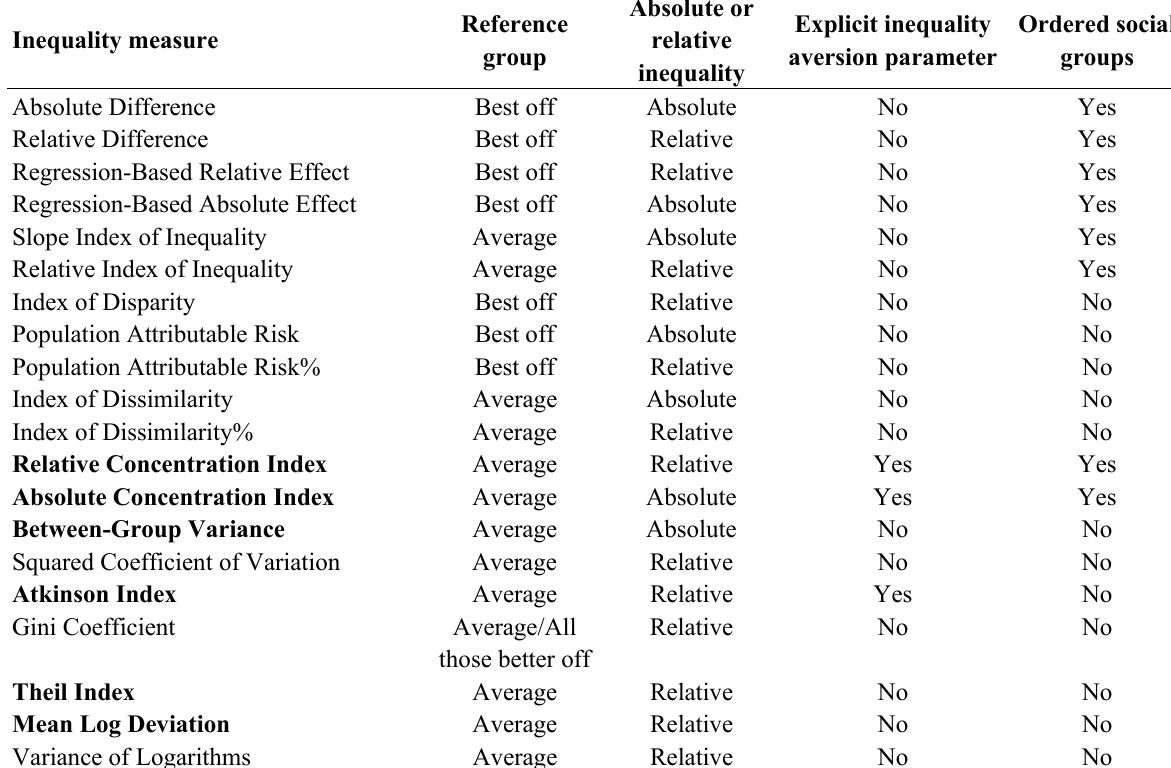
Absolute or Reference Explicit inequality Ordered social relative group aversion parameter groups inequality